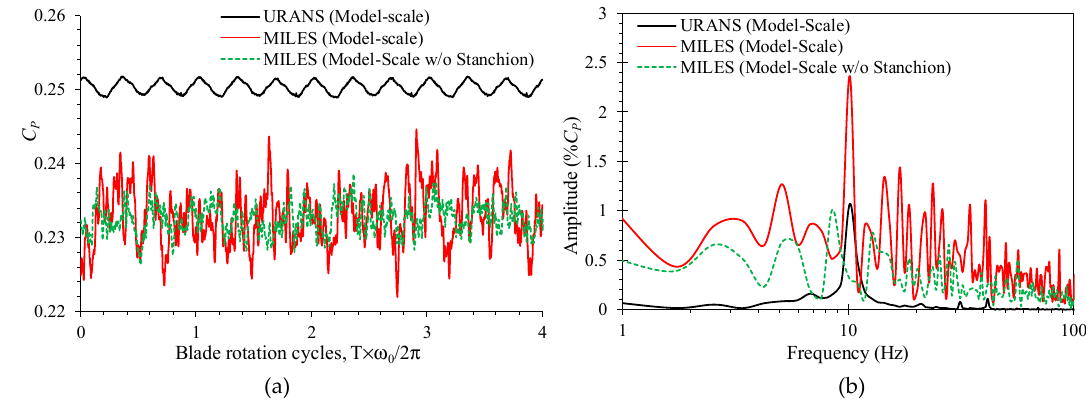
Figure 7. ( a ) Time history and ( b ) Fast Fourier Transform (FFT) of C P predictions obtained using URANS and Monotone Integrated Large Eddy Simulation (MILES) cases with and without stanchion.